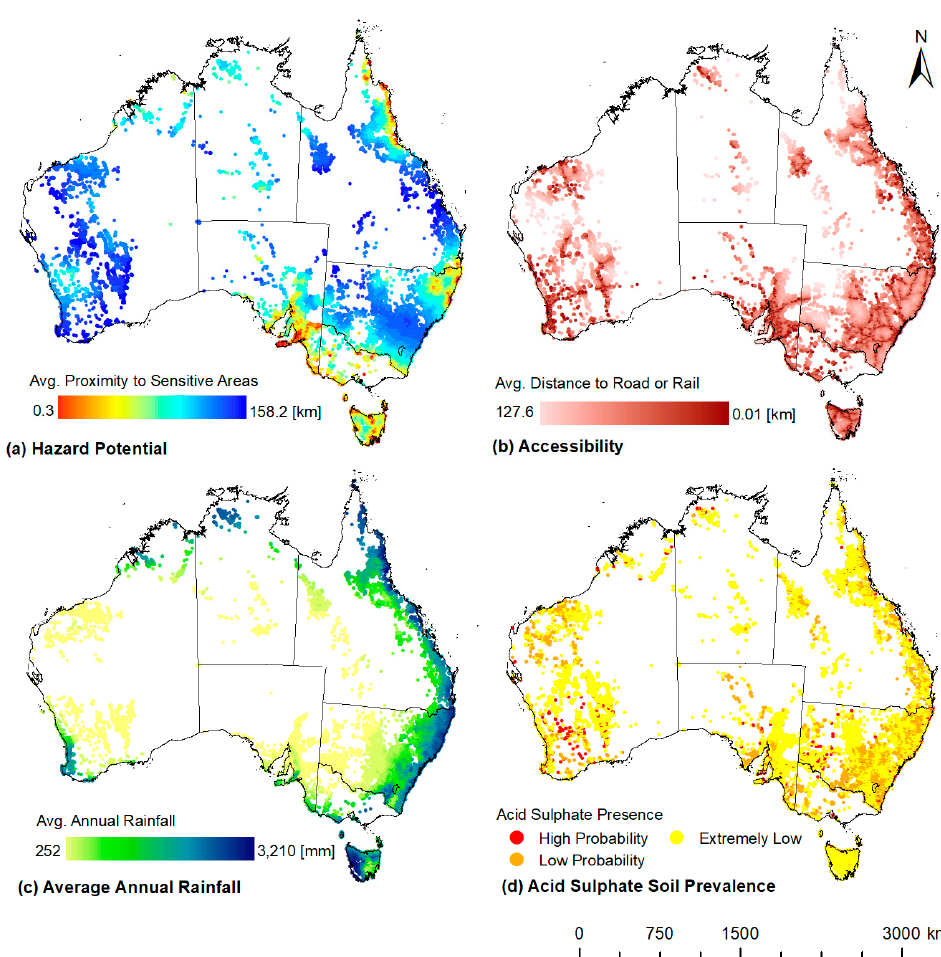
Figure 8. Spatial plots of inactive mines showing the distribution of ( a ) hazard potential, indicated by average proximity to sensitive areas d sen ; ( b ) accessibility, indicated by the average distance to nearest road and railway infrastructure; ( c ) average annual rainfall distribution; and ( d ) prevalence of acid sulphate soil.